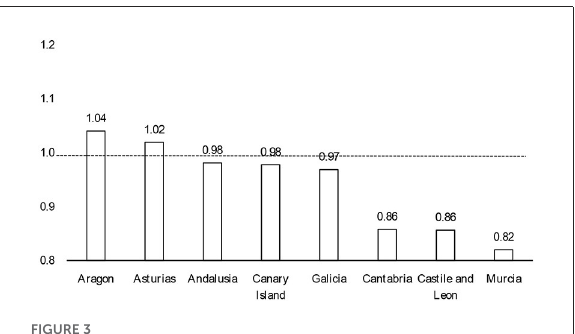
FIGURE3 Ratio of the incidence-rate ratios of opening secondary education with respect to